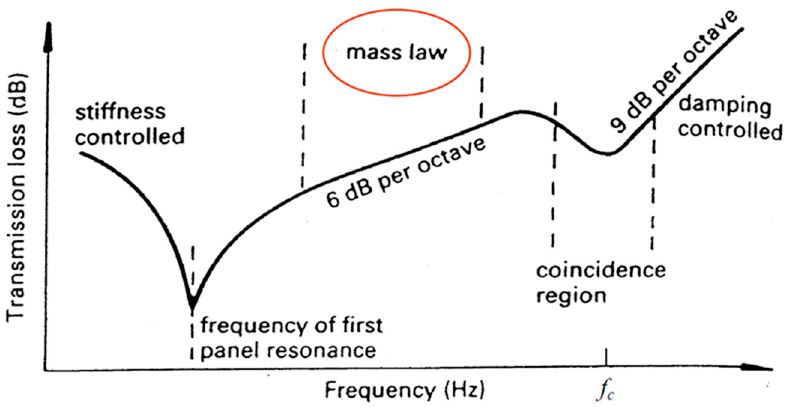
Figure 19. Classic transmission loss (TL) scheme according to frequency.